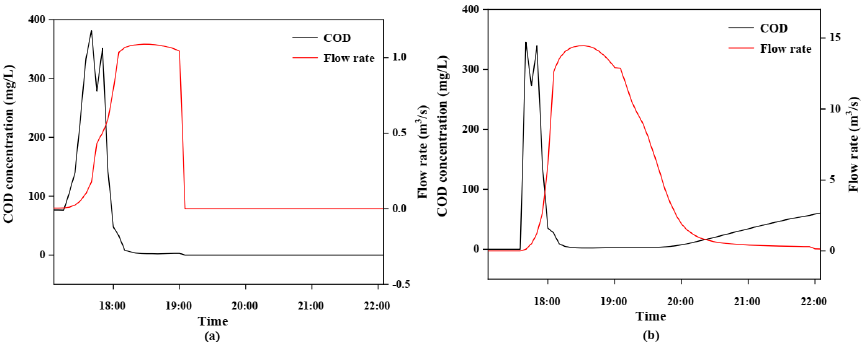
Figure 9. The simulation of traditional scheme: ( a ) COD interception of traditional scheme; ( b ) COD concentration of overflow of traditional